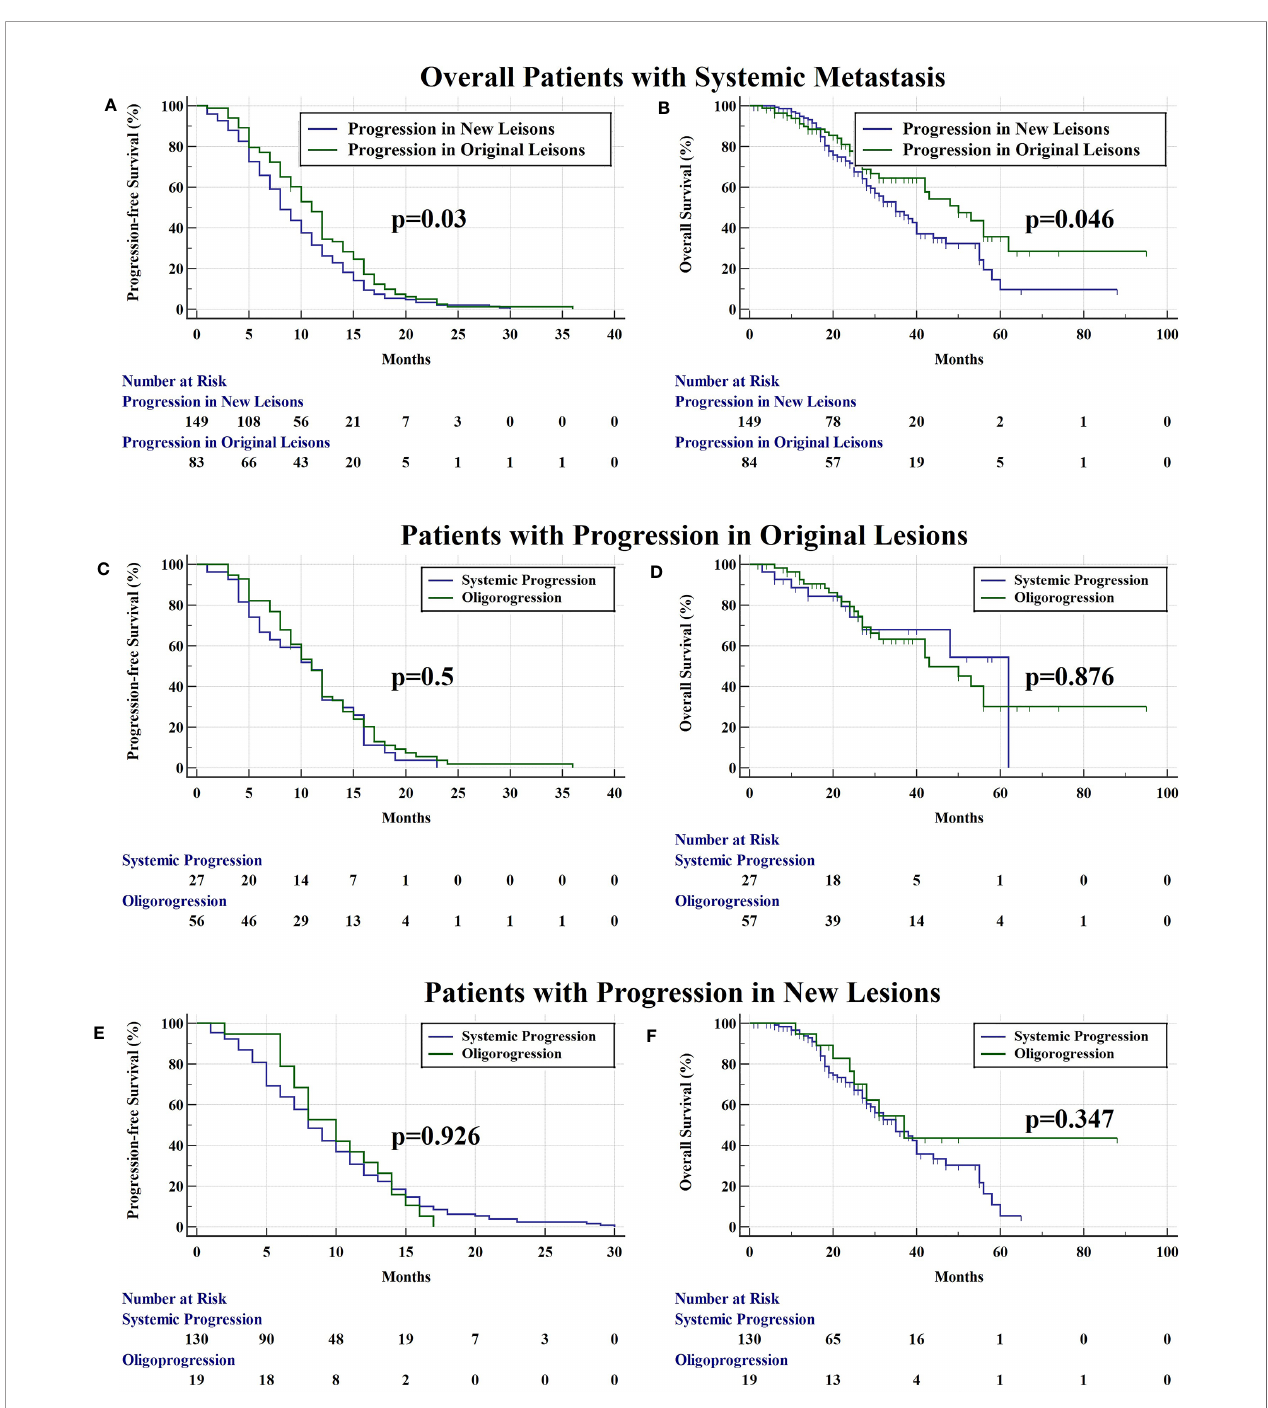
FIGURE 4 | (A) The PFS of patients with progression in original lesions and new lesions was 11 months and 8 months ( p = 0.03), respectively. (B) The OS of patients with progression in original lesions and new lesions was 50 months and 35 months ( p = 0.046), respectively. (C) Among patients with progression in original lesions, there were no signi fi cant difference of PFS (11 months vs . 11 months, p = 0.500) between patients with systemic progression and oligoprogression. (D) Among patients with progression in original lesions, there were no signi fi cant difference of OS (62 months vs . 43 months, p = 0.876) between patients with systemic progression and oligoprogression. (E) For patients with progression in new lesions, there existed no signi fi cant difference of PFS (8 months vs . 10 months, p = 0.926) between patients with systemic progression and oligoprogression. (F) For patients with progression in new lesions, there existed no signi fi cant difference of OS (35 months vs . 37 months, p = 0.347) between patients with systemic progression and